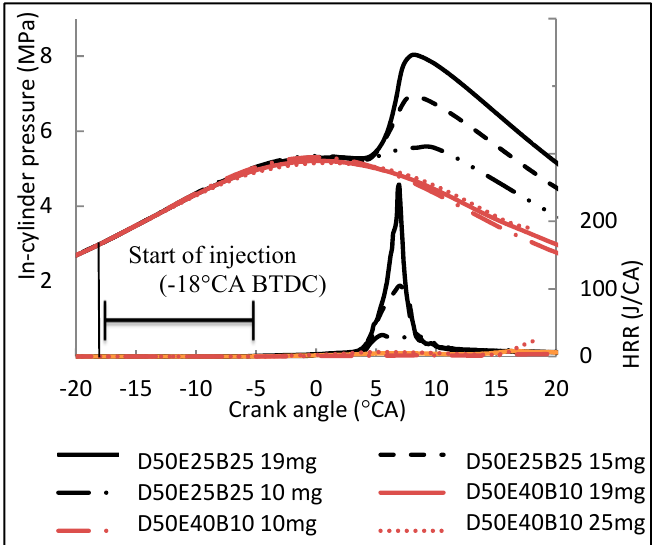
Figure 10. In-cylinder pressure and HRR graph of D50E25B25 and D50E40B10 blends against crank angle by using different injected mass.